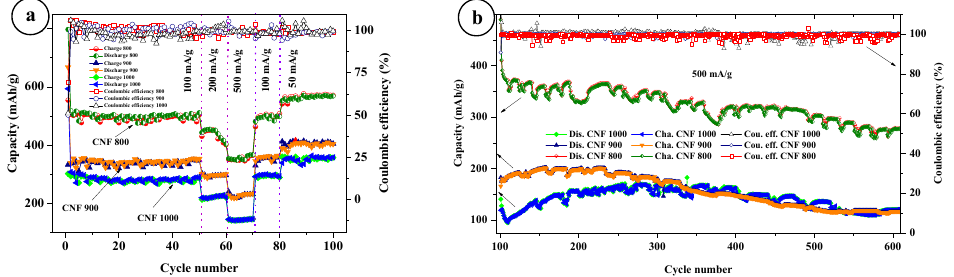
Figure 7. Cycling performance of CNFs at different currents ( a ), long cycles at a current density of 500 mA/g ( b ).